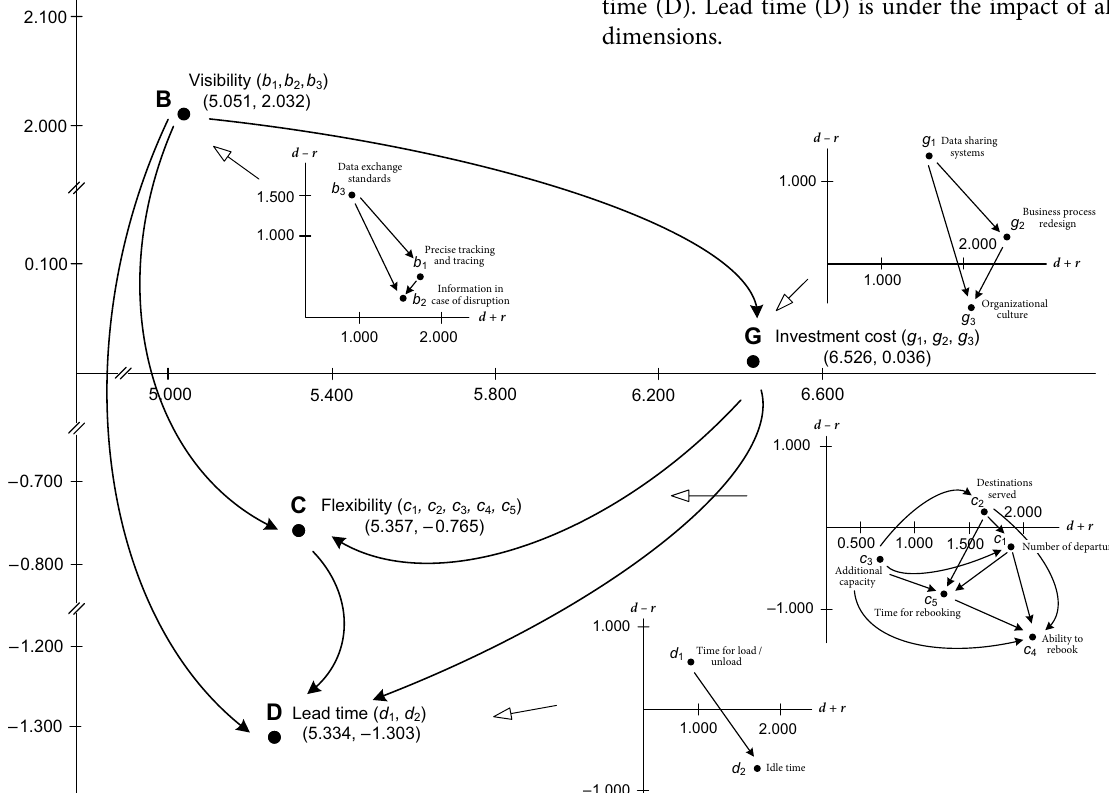
Figure 8. Causal diagram of total relationships: LSPs’